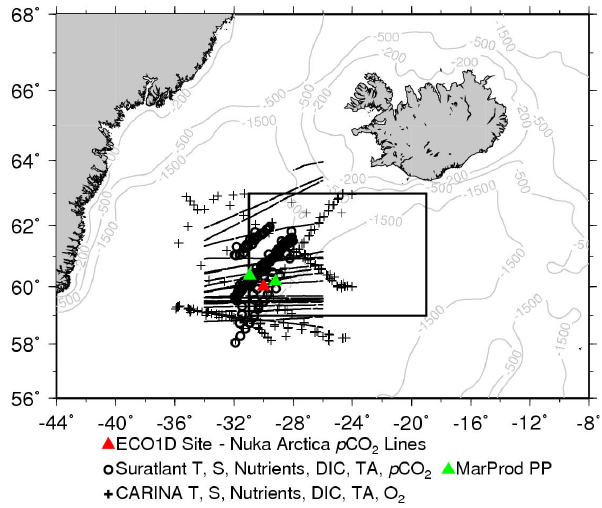
Fig. 1b. Map showing the spatial distribution of in situ PP, nutrients, and carbon data used for model evaluation. The rectangular box bounds the CPR standard area B6, from which taxonomy data were obtained for